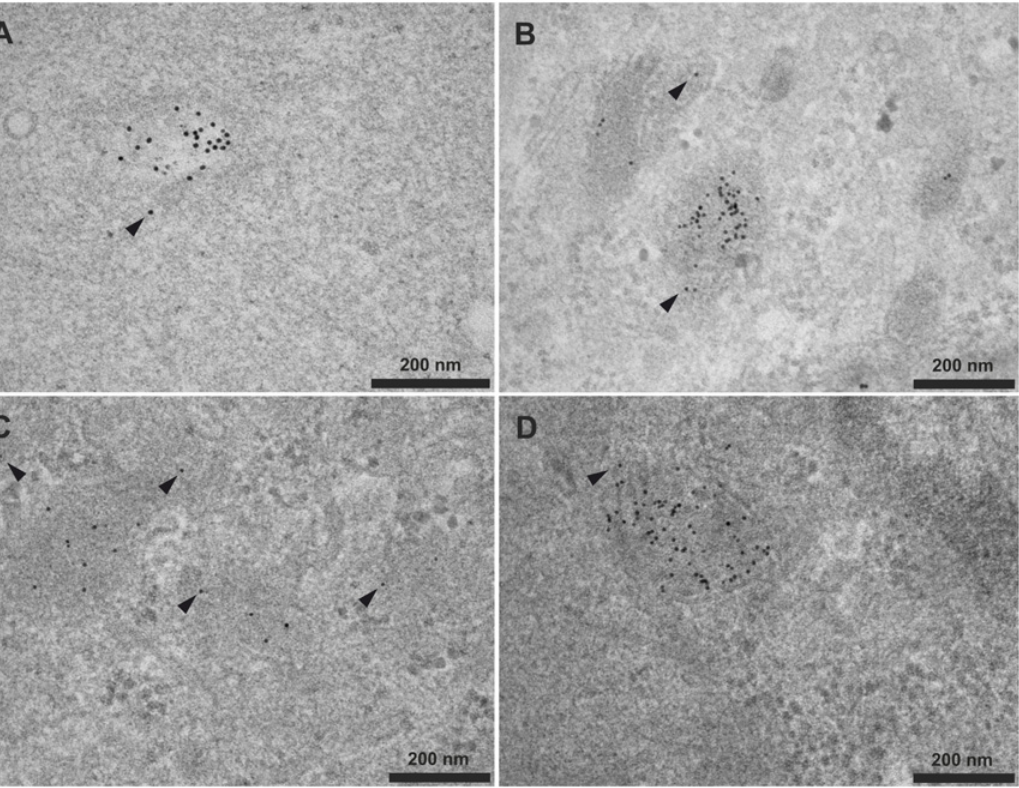
Fig 4. Attachment of HA2 to gold cores via the C-terminus versus N-terminus. HeLa cells were incubated for 4h with 10nm gold nanoparticles (6nM) capped with peptide monolayers of different compositions, fixed, and imaged by electron microscopy. Nanoparticle peptide monolayer compositions were: (A) 20% CCALNN-HA2 and 80% CALNN; (B) 20% HA2-NNLACC and 80% CALNN; (C) 50% CCALNN-HA2 and 50% CALNN; (D) 50% HA2-NNLACC and 50% CALNN. Arrowheads indicate particles around or outside endosomes. Additional images are available on figshare (10.6084/m9.figshare.874219, 10. 6084/m9.figshare.874153, 10.6084/m9.figshare.874033, 10.6084/m9.figshare.873852).